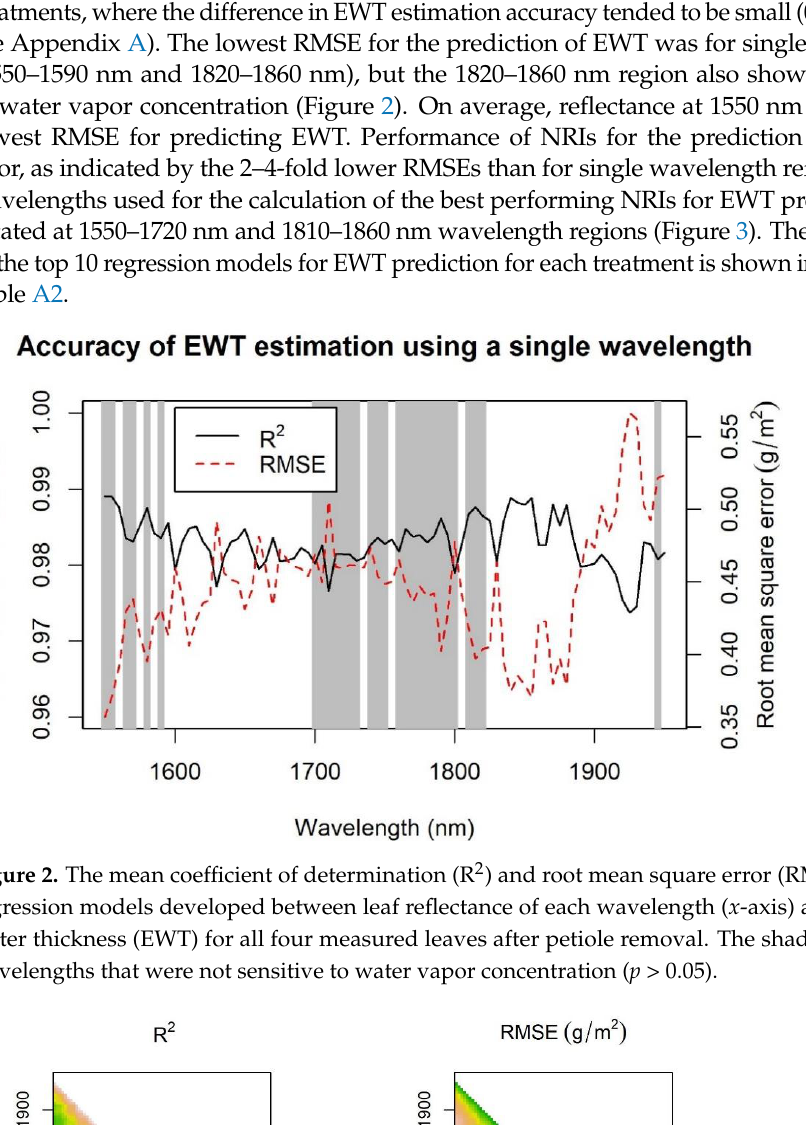
Figure 4. Observed and predicted equivalent water thickness (EWT, g m −2 ) of two silver birch leaves exposed to increasing VPD under constant levels of CO 2 concentrations and light intensity after detaching the leaf from the branch. Prediction was made using reflectance at 1550 nm wavelength as a predictor. Reflectance wavelength was selected based on the lowest RMSE in the estimation of EWT. The line represents 1:1 relationship. The estimates were non-biased. Reflectance was trans- formed to EWT with coefficients of -4310.4 and -4631.1, and constants of 700.7 and 715.3 for leaves 1 and 2, respectively.